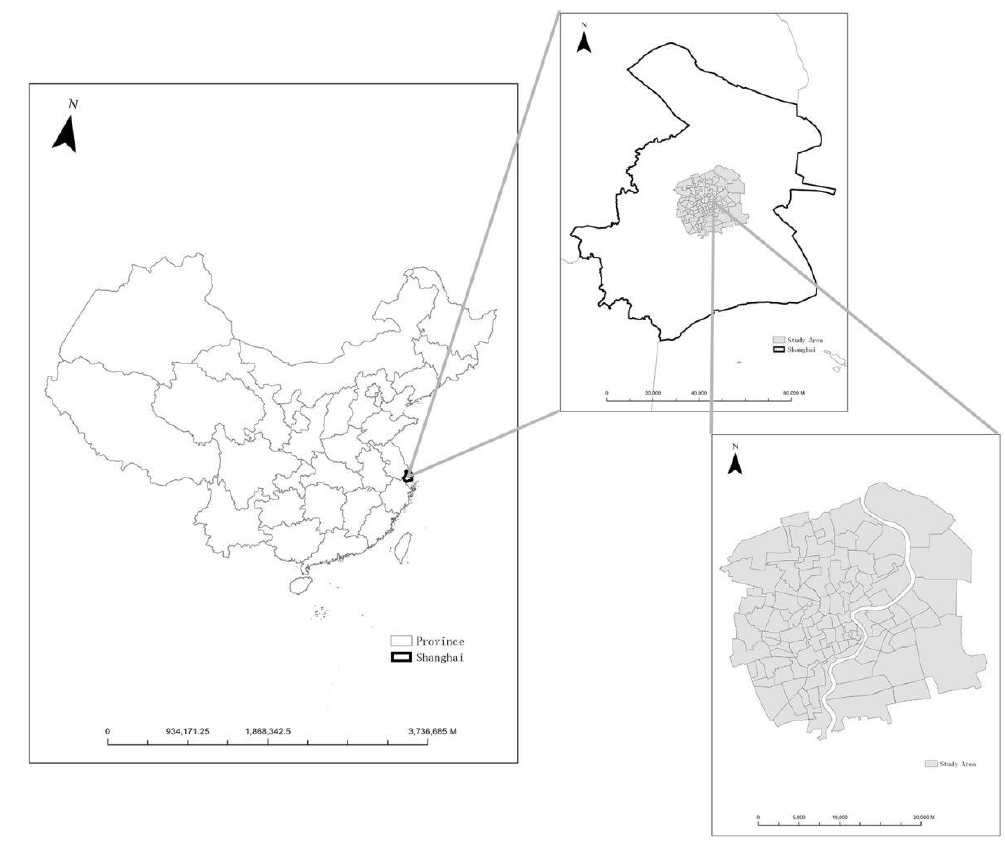
Figure 1. Study area.